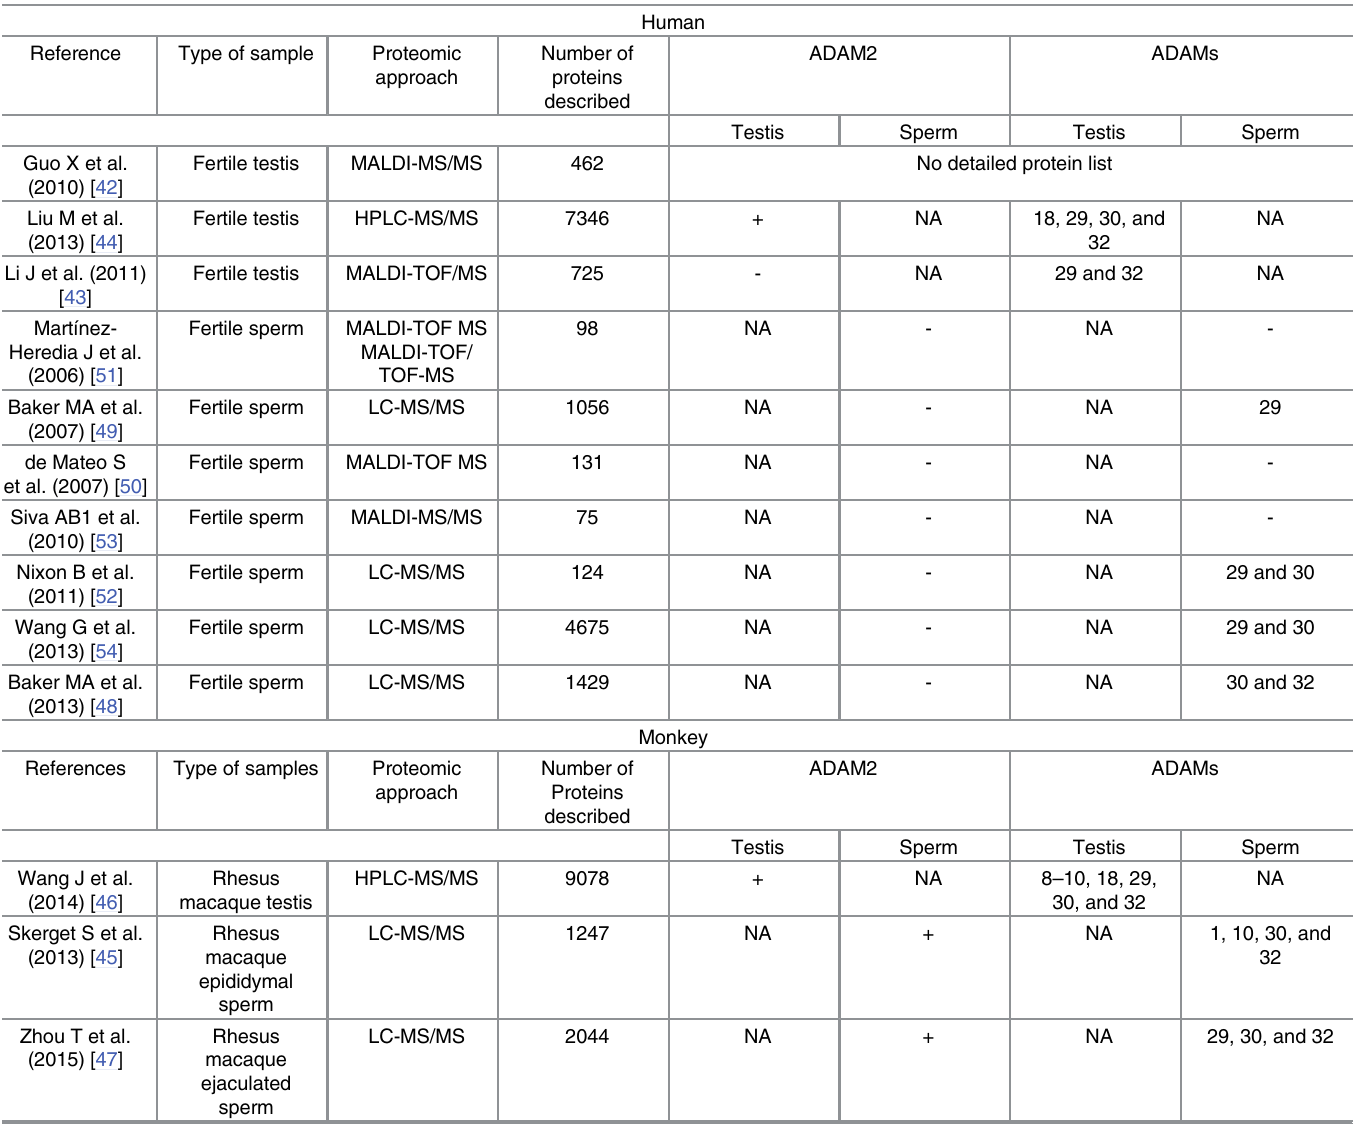
Table 1. Previous proteomic